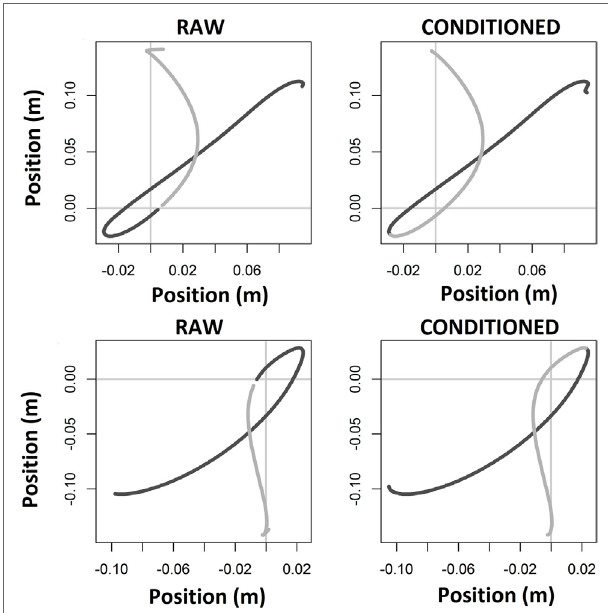
FiguRe 5 | Exemplars in the plane of movement: data from two files are plotted. Raw data (left) show partitioning within the bounds of center target (data break near origin); conditioned data (right) show partitioning at movement